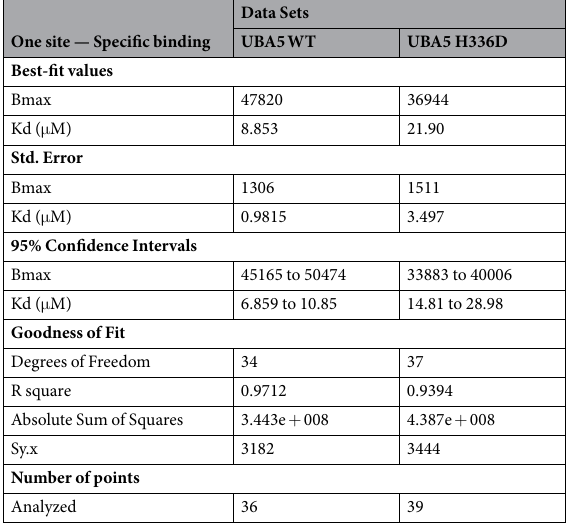
Table 4. K D values and statistics from fit to one site specific binding of